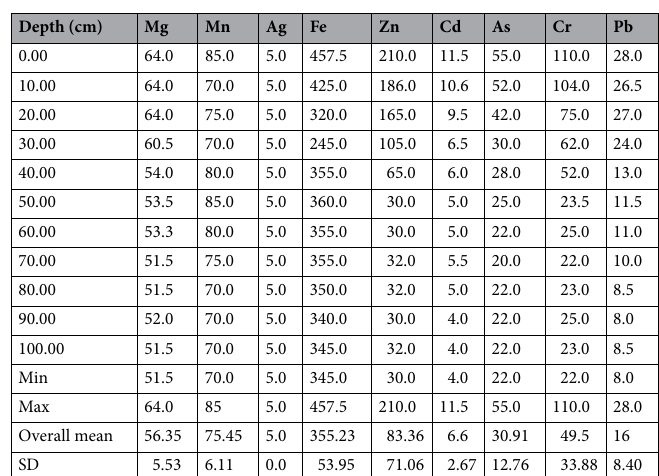
Table 5. Mean concentration of HMs with depth within the station in